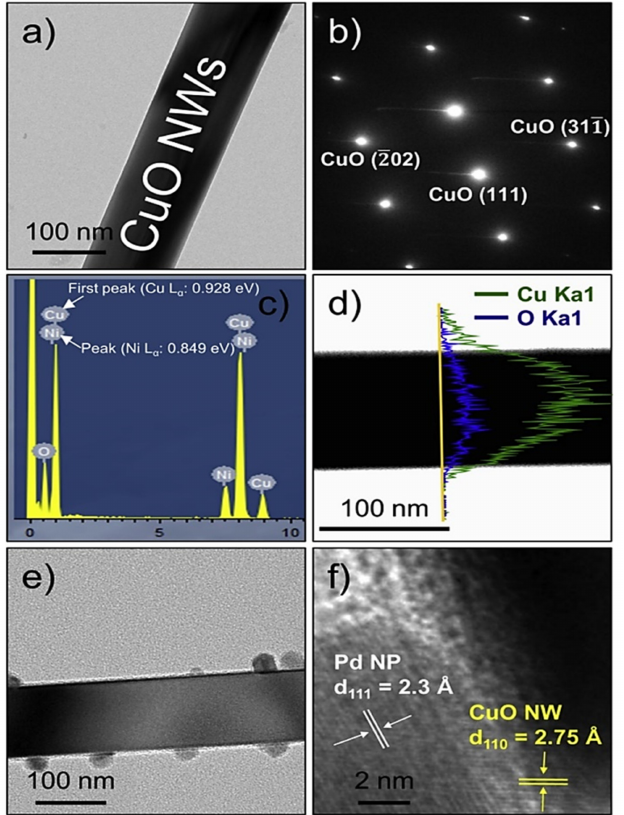
Figure 4. ( a ) TEM, ( b ) SAED, ( c ) EDS, and ( d ) EDS line profiles of CuO NW; ( e ) TEM and ( f ) HR-TEM images of Pd-loaded CuO NW. Reprinted from [27] with permission from